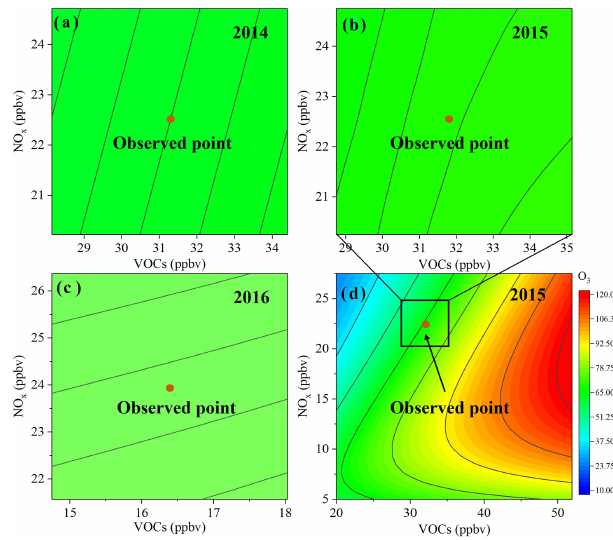
Figure 4. Ozone formation sensitivity curves from 2014–2016 ( a, b, c : calculated by the RF model for 2014, 2015, and 2016, re- spectively, d calculated by the OBM for